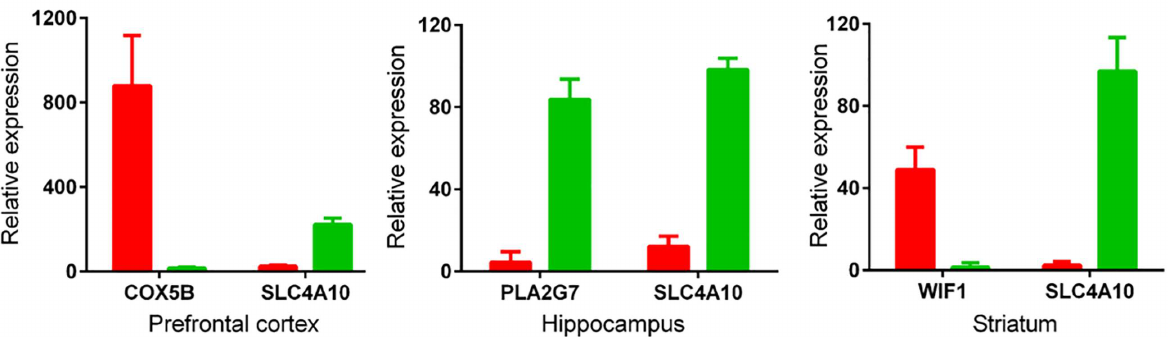
Fig 5. Confirmation of Affymetrixchip data by qRT-PCR. GAPDH was used to normalizegene expression. The relative expression of each gene was calculated as log2 of 2 - 4 Ct values. Data are expressedas mean ± SD. Red bars represent human and green bars